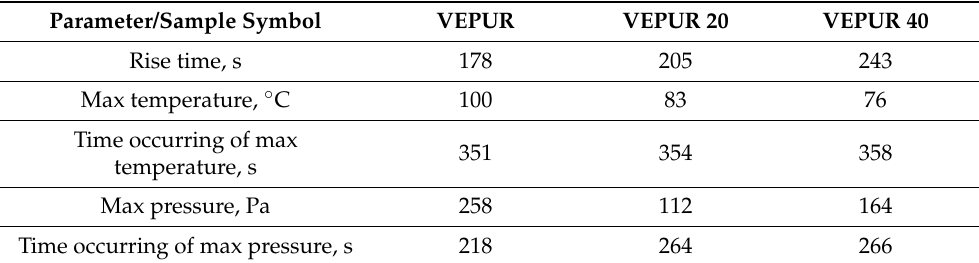
Table 4. List of selected parameters of the foam synthesis process.